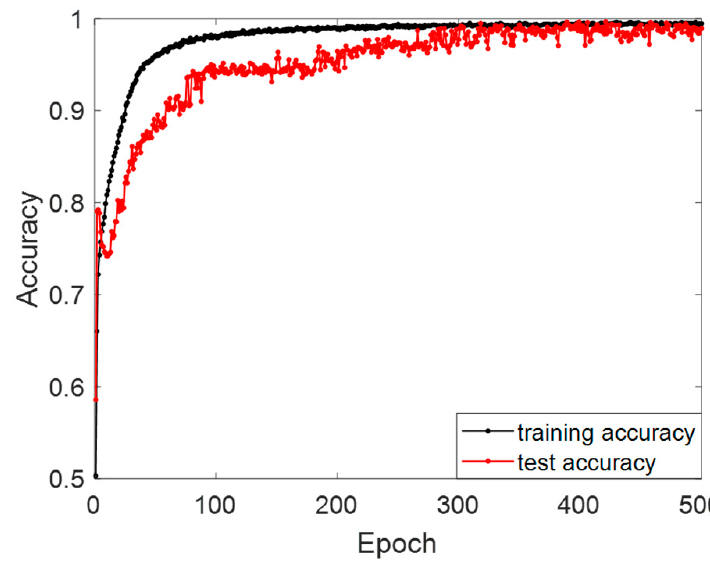
Figure 8. CNN training performance with the augmented database.